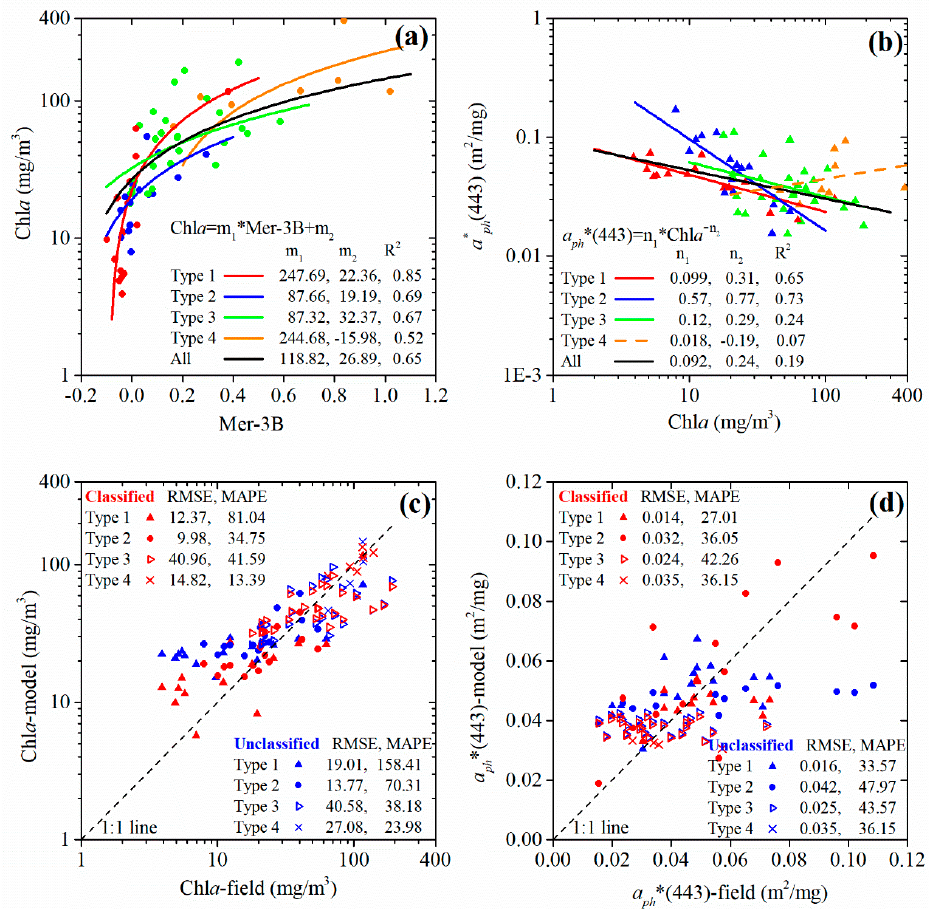
Figure 7. ( a ) Mer-3B versus field-measured Chl a content data for OLCI validation of each OWT and all data. ( b ) Chl a versus a *ph (443) for OLCI validation of each OWT and all data. ( c ) Comparison of the field-measured Chl a and model-derived Chl a using unclassified models and classified models for each OWT and all data. ( d ) Comparison of the field-measured a *ph (443) and model-derived a *ph (443)